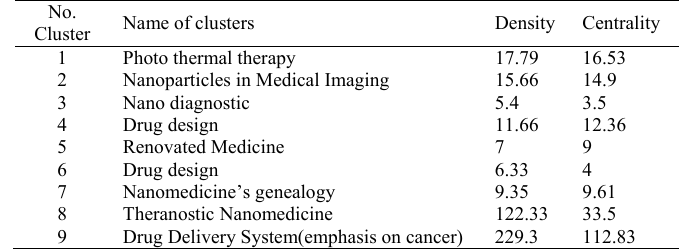
Table 5: The centrality and density data of clusters from co-word analysis. Table 5. The centrality and density data of clusters from co-word analysis.